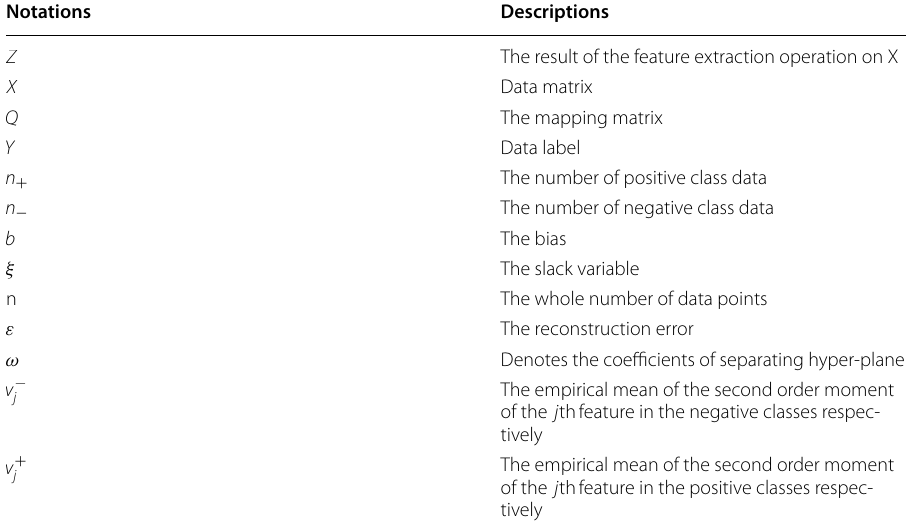
Table 1 Frequently used notations and descriptions